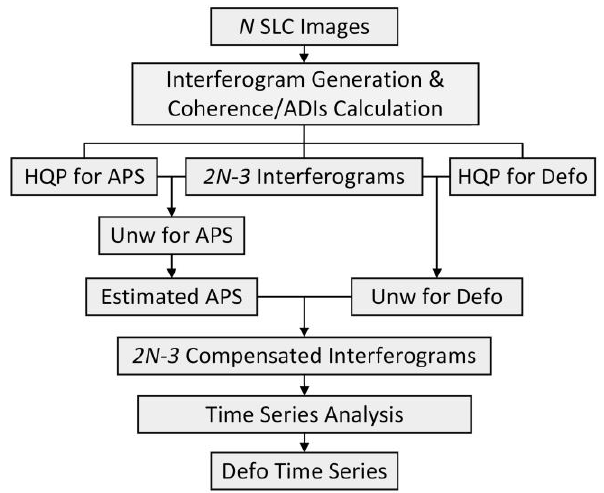
Figure 5. The procedure of compensating the APS by the proposed models. HQP stands for the high-quality points selected by coherence and amplitude deviation index. Unw is the unwrapped phase. Defo means deformation.